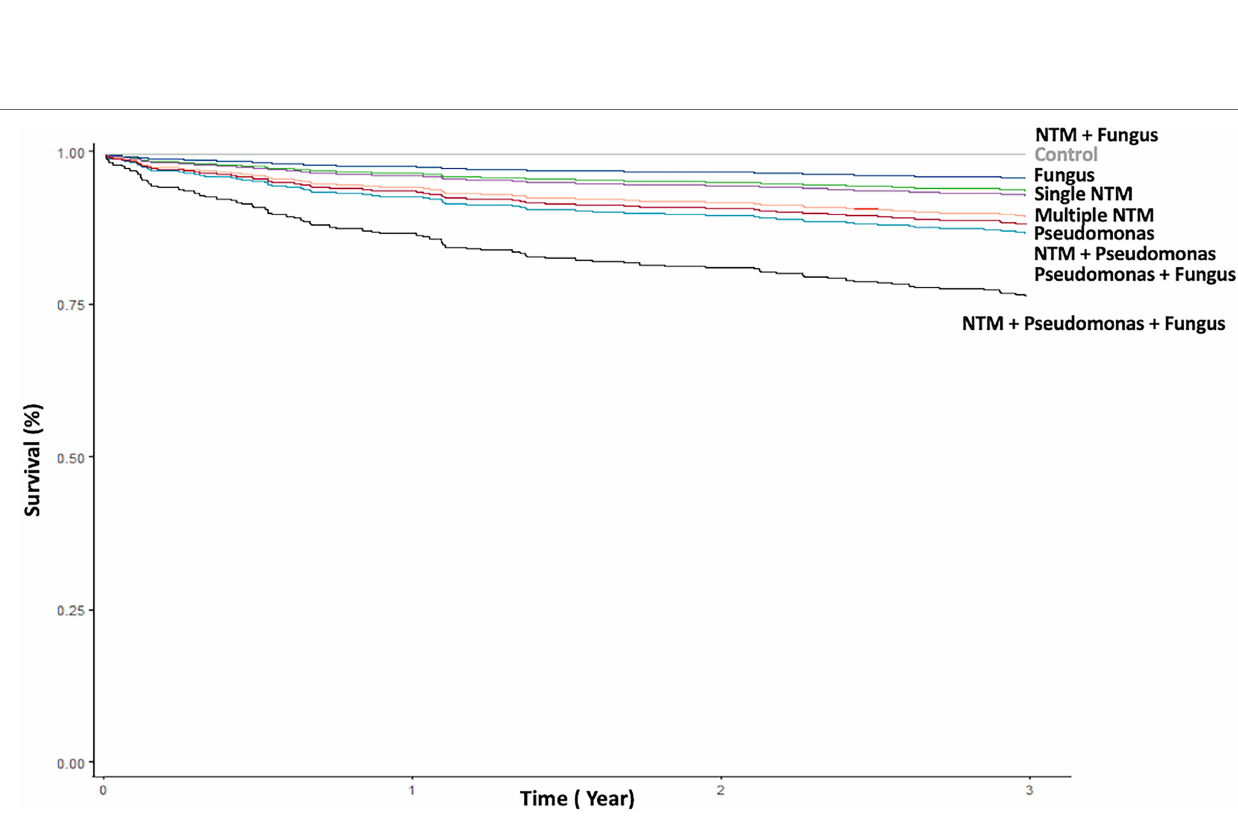
FIGURE 3 | Kaplan–Meier curve of death according to different pathogen isolates from sputum. NTM, nontuberculous